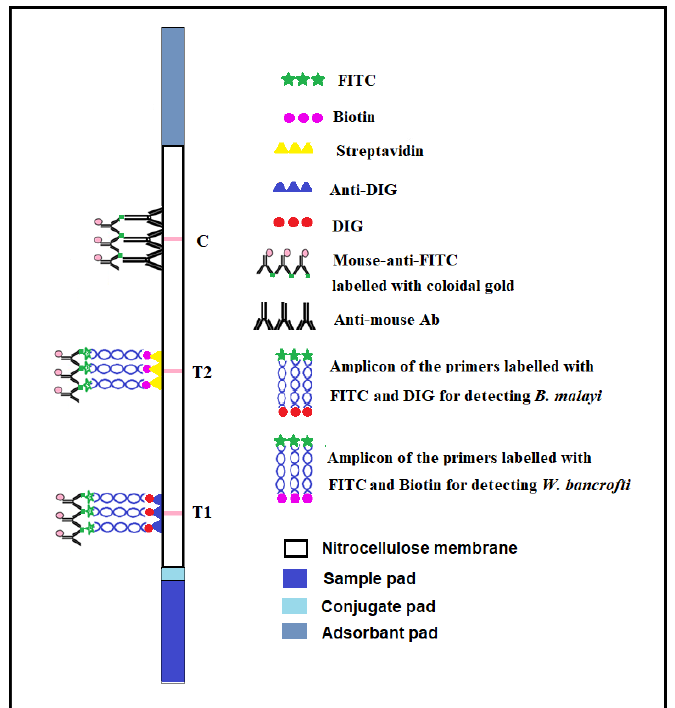
Figure 2. Schematic diagram reveals the principle of the duplex lateral flow dipstick (DLFD) for lymphatic filariae DNA detection. lymphatic filariae DNA